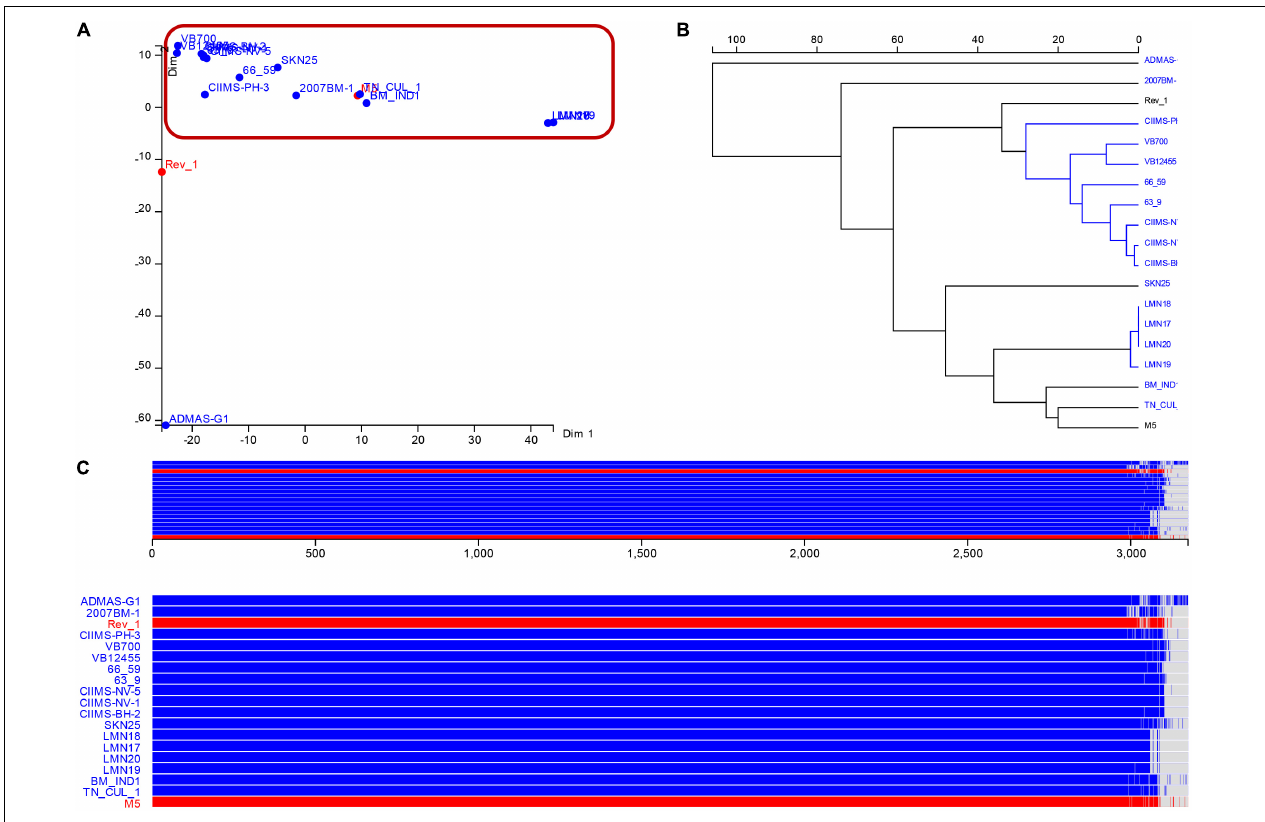
FIGURE 4 | Results of pangenome analysis (A) . Multidimensional scaling (B) . Pangenome phylogeny (C) . Schematic representation of core and accessory genes among the various genomes analyzed. Indian strains are depicted in blue color and vaccine strains in red color